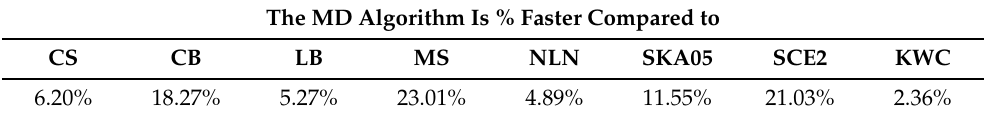
Table 3. Percent that the MD algorithm is faster than the other algorithms.